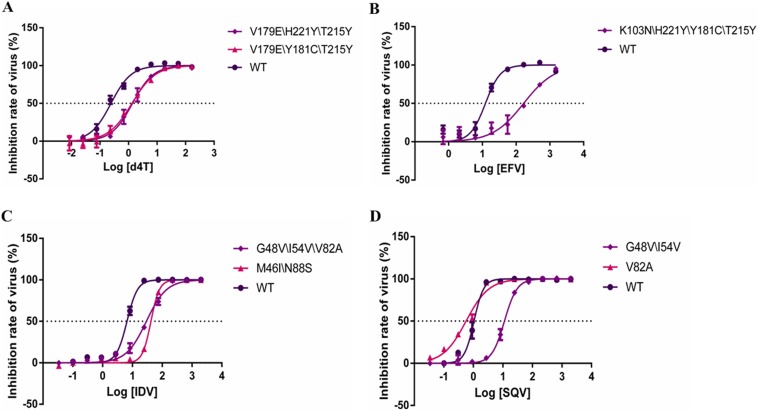
Curves of the dose-response of selected drugs.x axes indicate log of drug concentration (nM), y axes indicate the inhibitor rate of virus (%). (A) is the curve of the dose-response of 3 viruses (V179E\H221Y\T215Y, V179E\Y181C\T215Y and WT NL4.3) in d4T. (B) is the curve of the dose-response of 2 viruses (K103N\H221Y\Y181C\T215Y and WT NL4.3) in EFV. (C) is the curve of the dose-response of 3 viruses (G48V\I54V\V82A, M46I\N88S and WT NL4.3) in IDV. (D) is the curve of the dose-response of 3 viruses (G48V\I54V, V82A and WT NL4.3) in SQV.